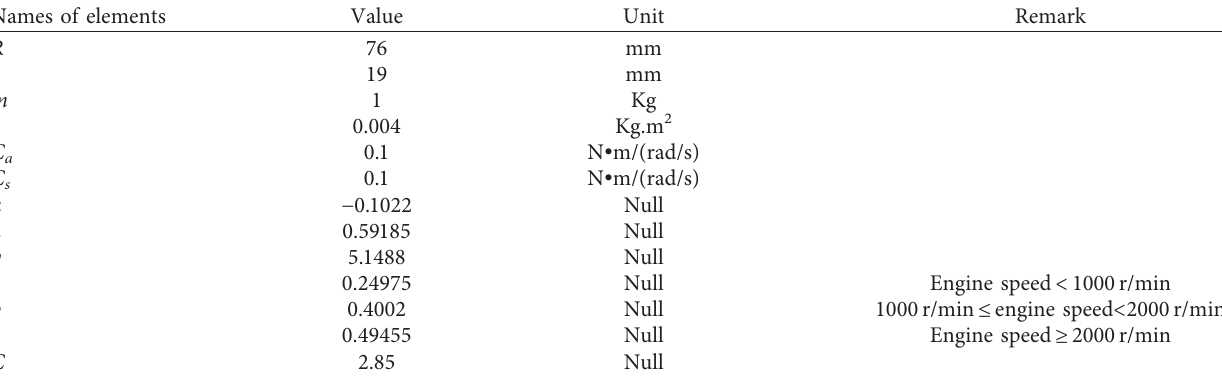
Table 2: Model parameters of the DMF with the bifilar CPVA.